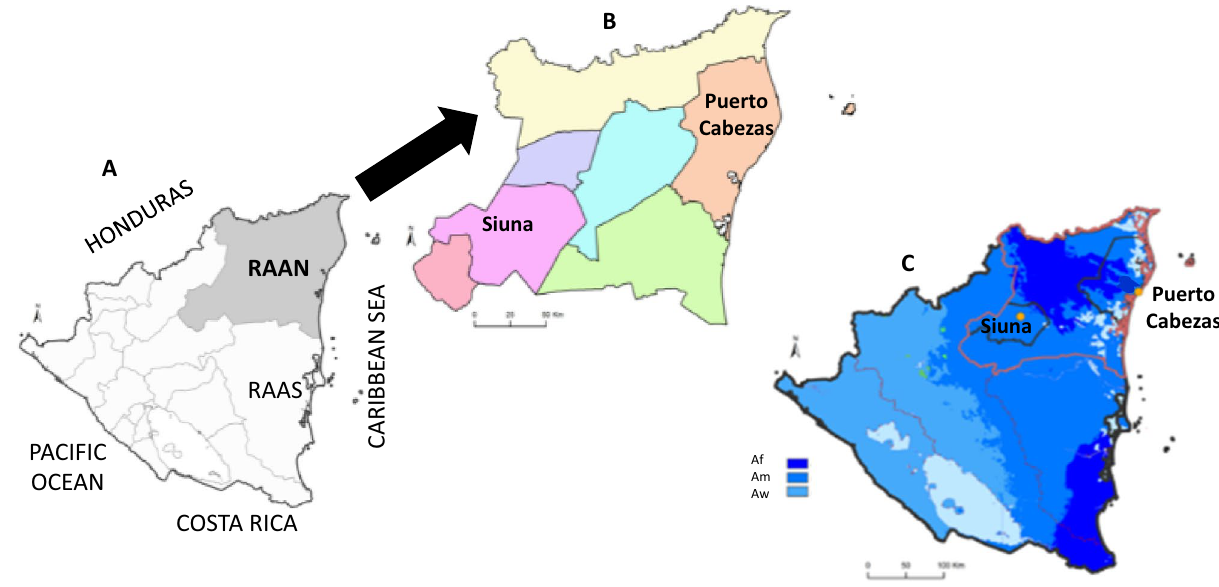
Figure 1. ( A ) Map of the study area Región Autónoma Atlántico Norte (R.A.A.N.) in Nicaragua; ( B ) Detail of municipalities of R.A.A.N.; ( C ) Different climatology conditions: Tropical rainforest climate (Af) in Puerto Cabezas; Tropical monsoon climate (Am) in Siuna; and tropical savanna climate with dry-winter characteristics (Aw) (according to Köppen-Geiger climate classification). We use administrative area spatial data from the Global Administrative Area Database (GADM) v3.6 and the Köppen-Geiger climate classification system at 1 km resolution for the present (1980-2016) (Beck et al. 2018: https:// doi. org/ 10. 1038/ sdata. 2018. 214) using QGIS software v3.22.5 (https:// www. qgis. org/ en/ site/) to represent the study area and its climate